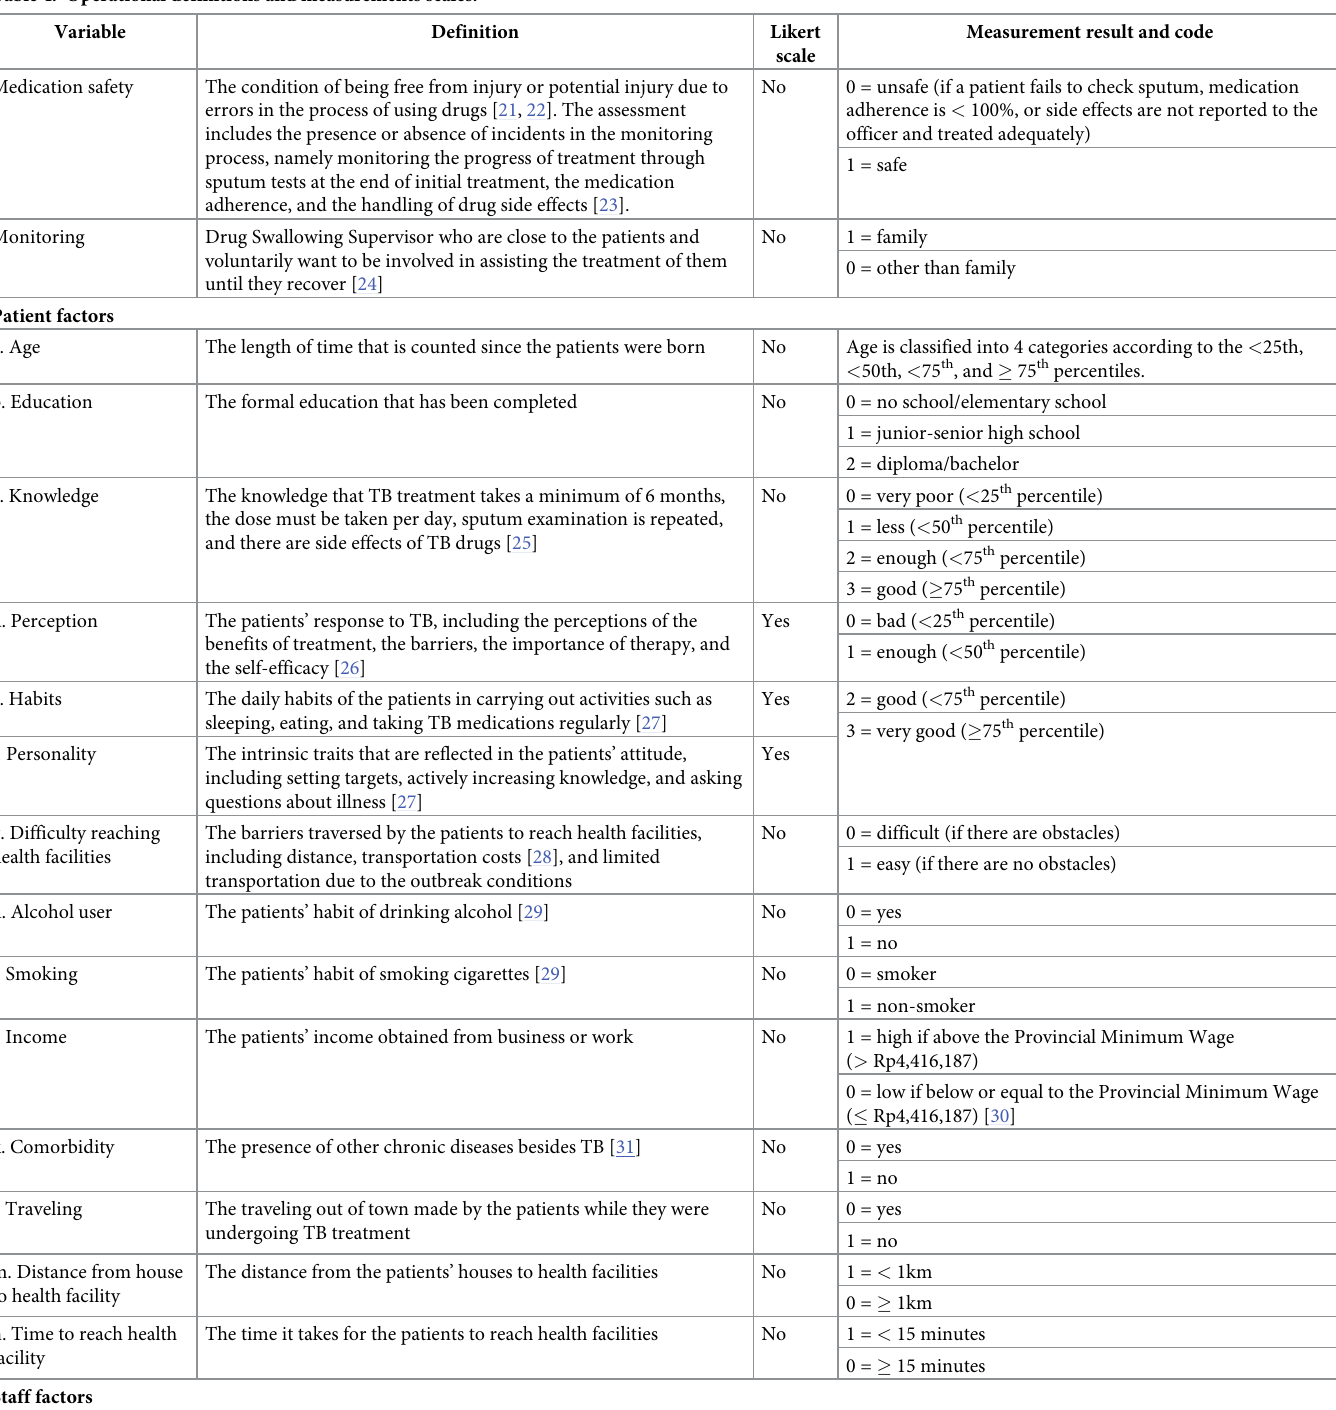
Table 4. Operational definitions and measurements